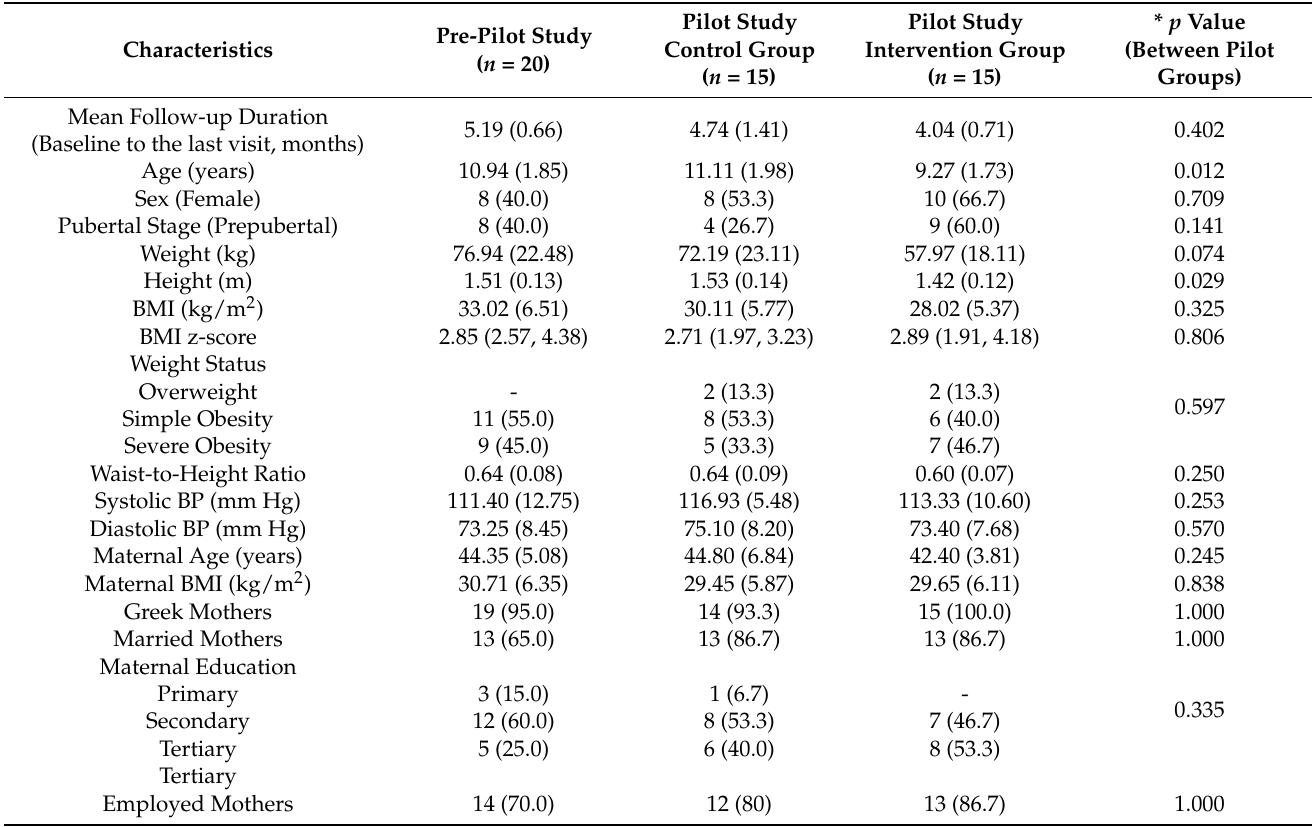
Table 2. Baseline